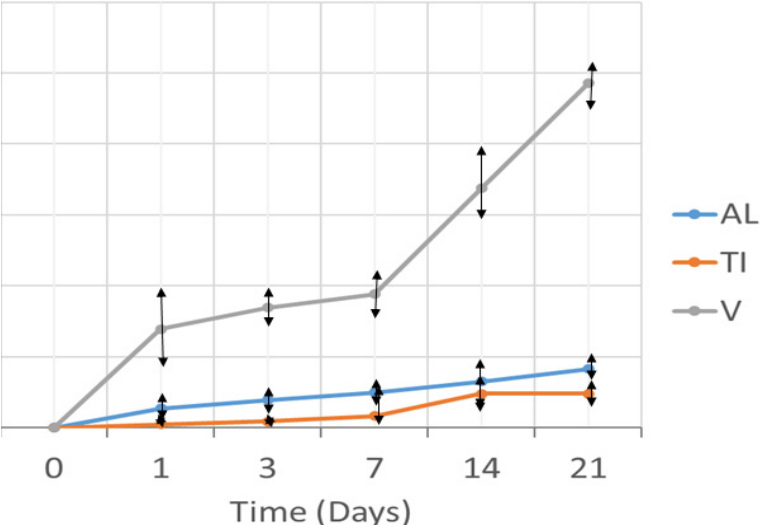
Figure 3. Titanium (Ti), Aluminum (Al), and Vanadium (V) ion release curve as a function of expo- sure time.